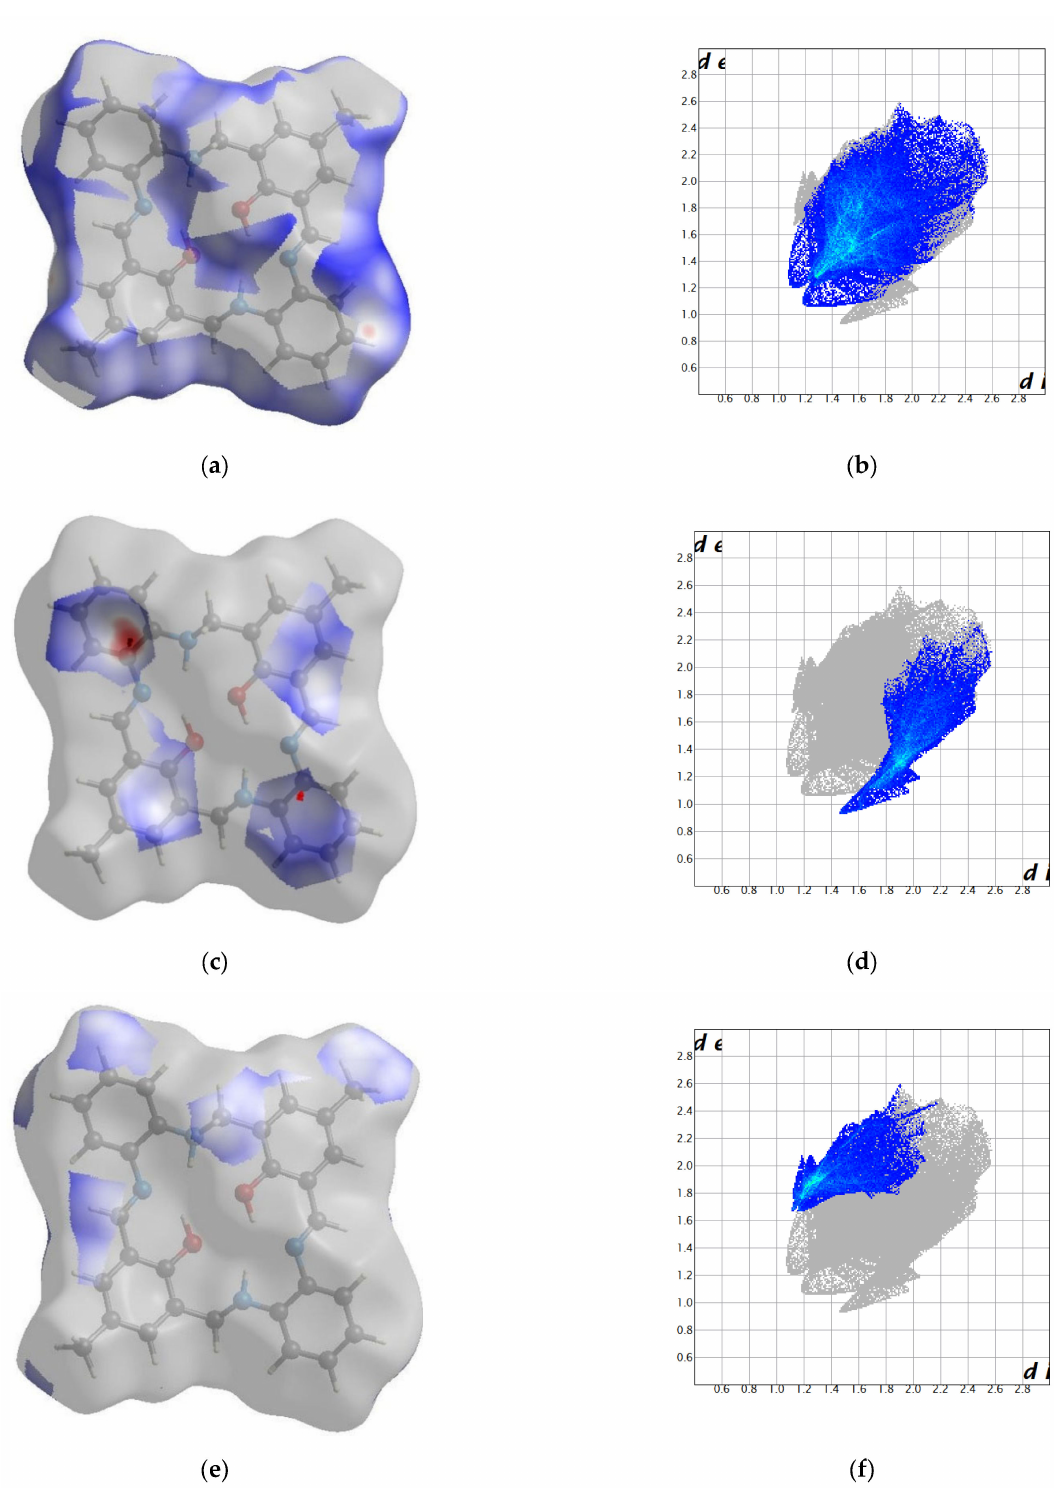
Figure 3. Hirshfeld surfaces and fingerprints of selected interactions created in the crystal network of L1 : ( a ) Hirshfeld surface for H . . . H; ( b ) fingerprint for H . . . H (50.7%); ( c ) Hirshfeld surface for C . . . H (red markers correspond to the large spike at 1.5; 0.9); ( d ) fingerprint for C . . . H (19.9%); ( e ) Hirshfeld surface for H . . . C; ( f ) fingerprint for H . . . C (15.1%) for O14 molecule In brackets, there is given surface area included as a percentage of the total surface